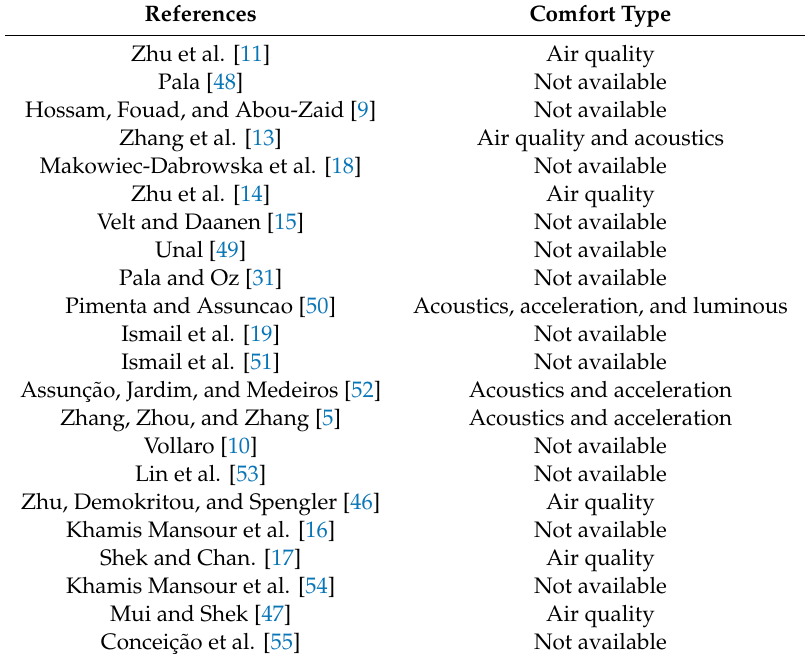
Table 9. Types of comfort evaluated on thermal comfort studies in bus cabin